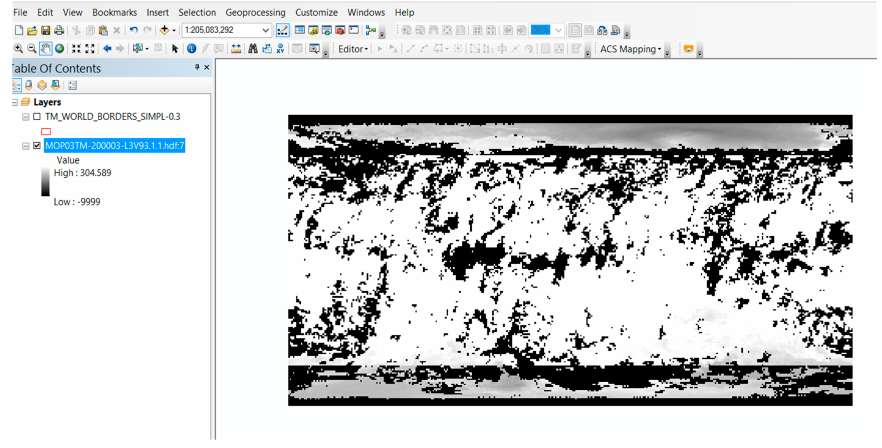
Figure 5. Image displayed by interpreting a NoData value (–9999) as a normal value.